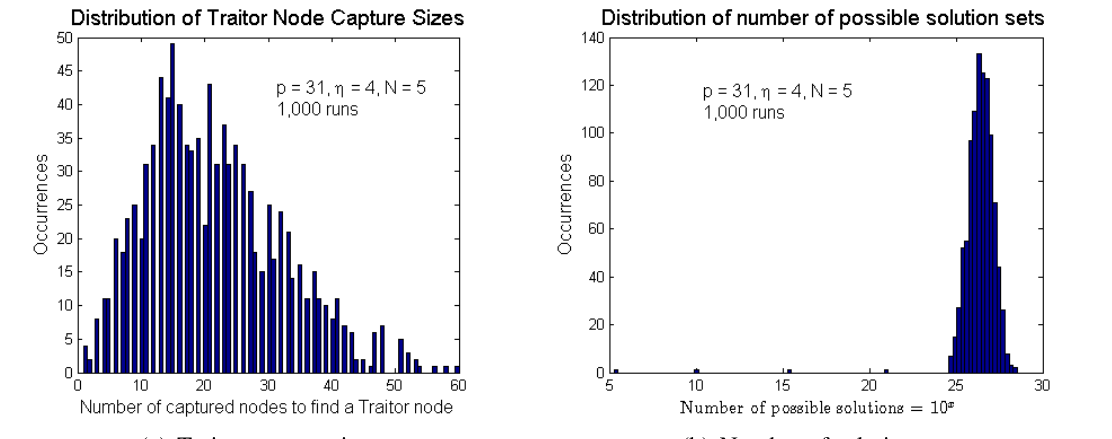
(a) Traitor capture sizes (b) Number of solution